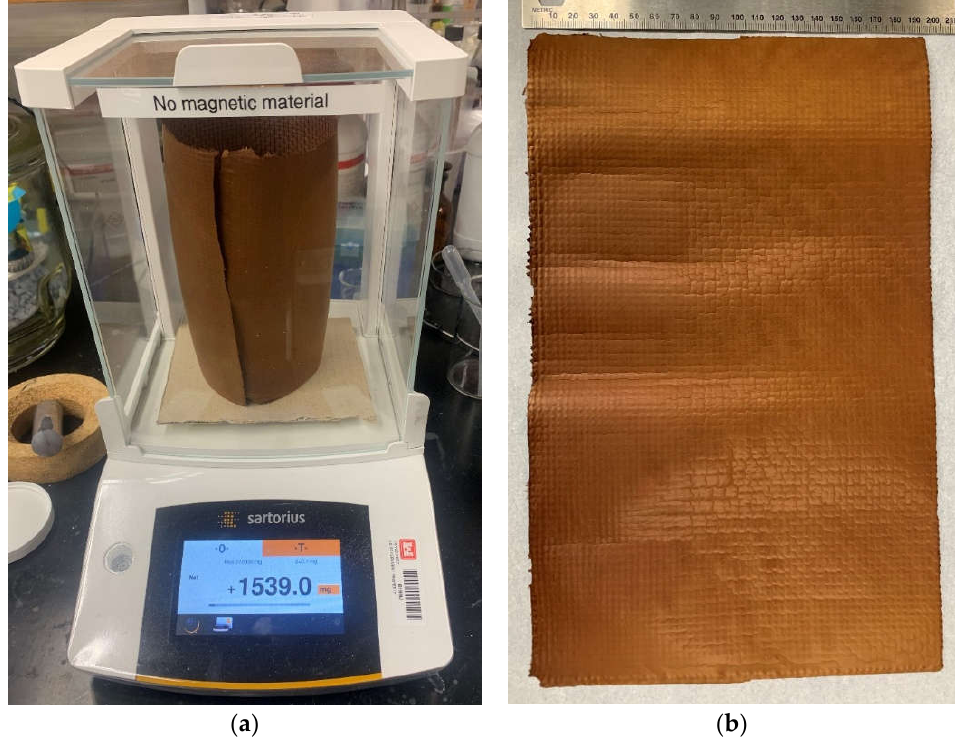
Figure 7. Size and weight measurements of stabilized polyacrylonitrile media for trial #6. ( a ) Detached media weight measurement on digital scale. ( b ) Size measurement.